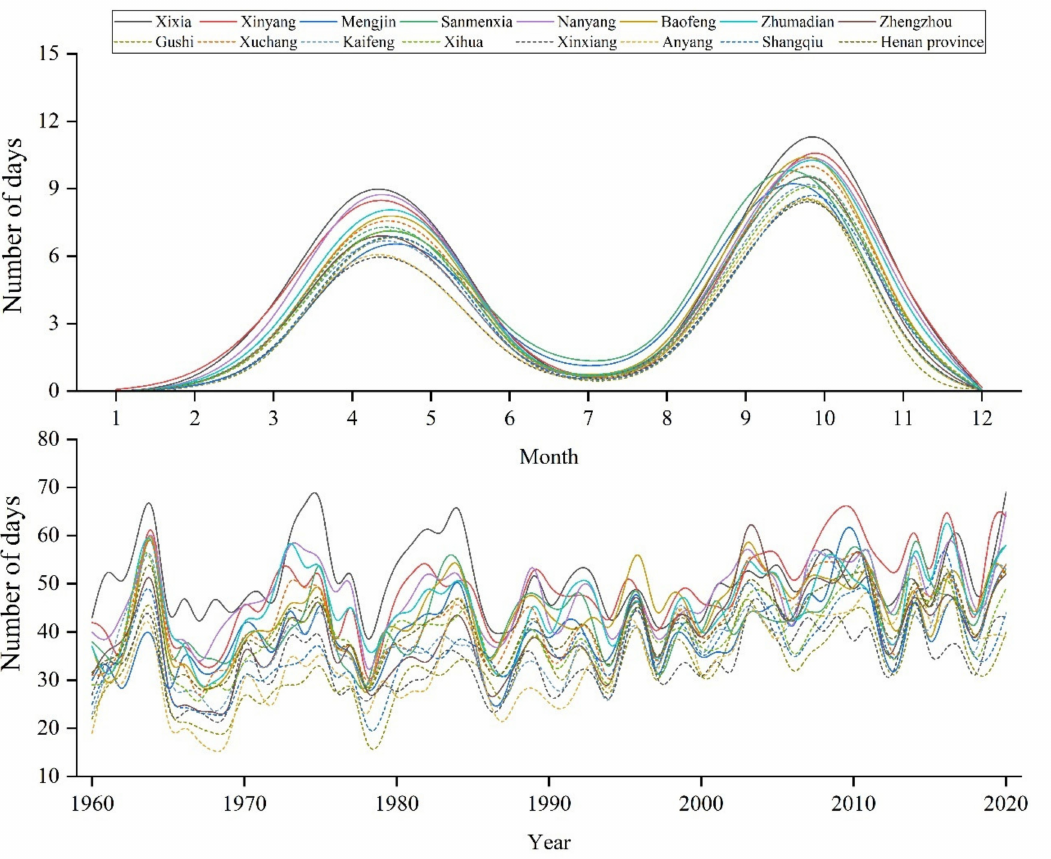
Figure 4. Statistics related to the monthly and annual days when the TCCI reaches the comfort level at various meteorological stations in Henan Province and in the whole province (average of all